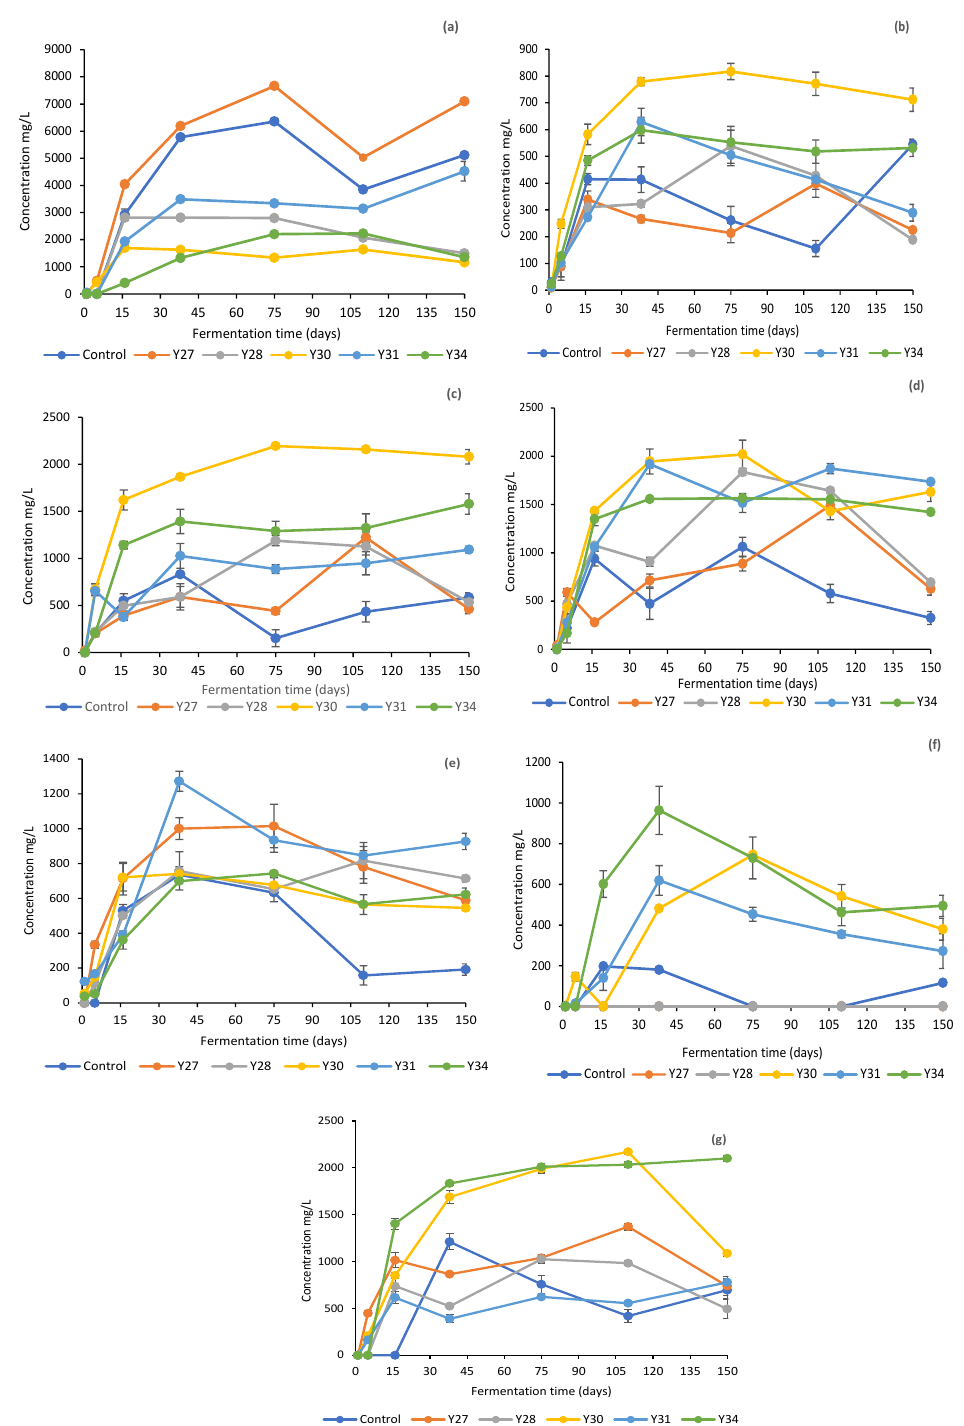
Figure 3. Changes in the concentrations of organic acids and ethanol in the brines during processing of cv. Kalamata natural black olives with selected yeast starters. ( a ) Lactic acid, ( b ) acetic acid, ( c ) citric acid, ( d ) malic acid, ( e ) succinic acid, ( f ) propionic acid, and ( g ) ethanol. Data points are mean values of duplicate fermentations ± standard